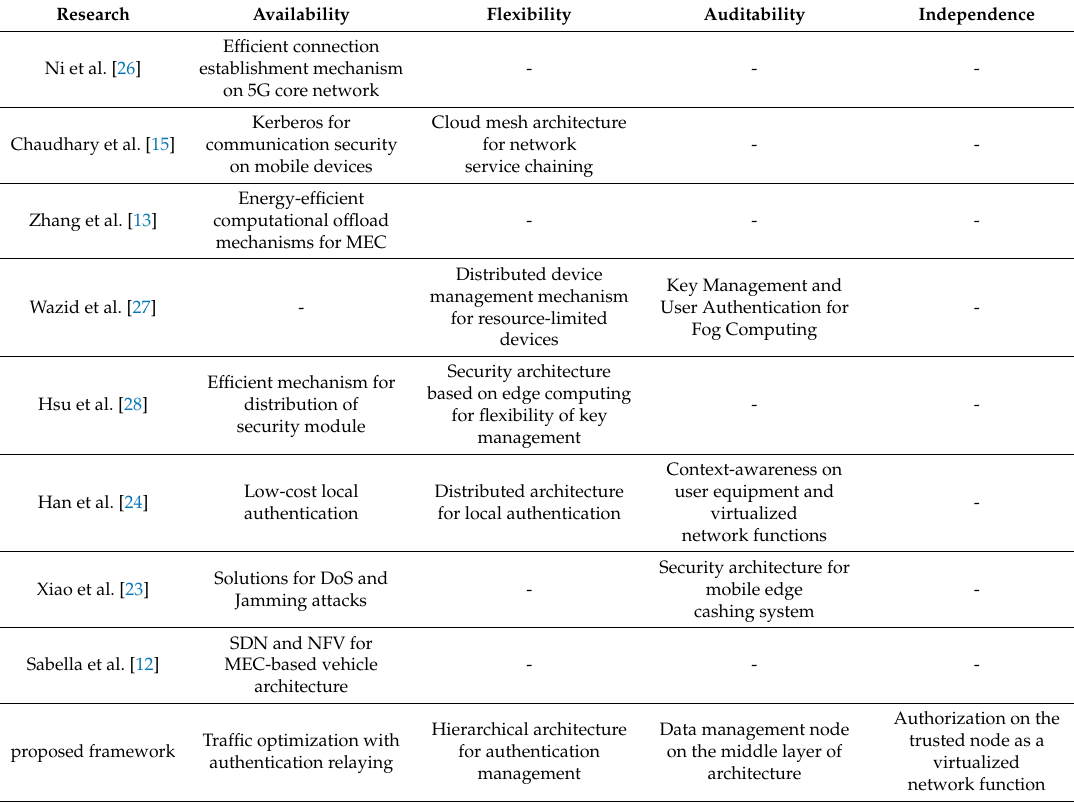
Table 1. Comparison of considerations between the previous works and the proposed